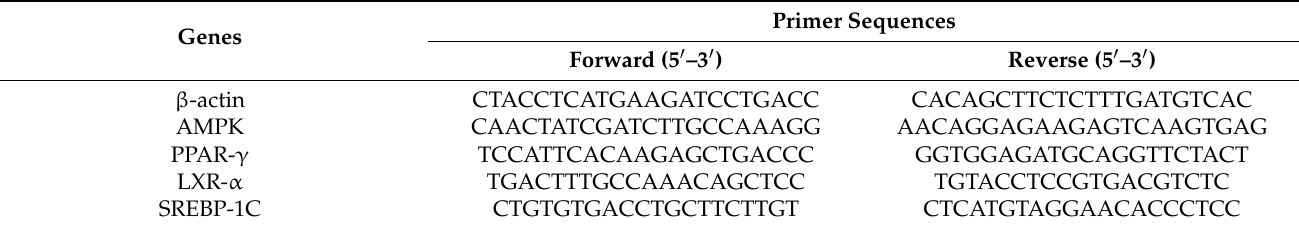
Table 2. Primer sequences used for